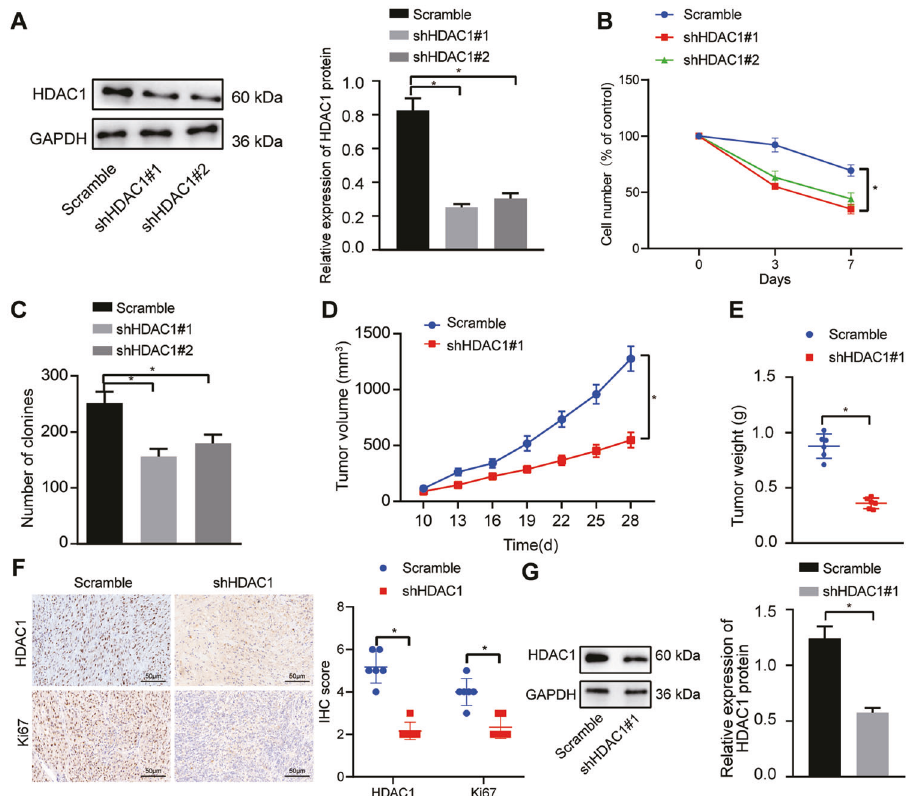
Fig. 2 Downregulation of HDAC1 represses the growth of CC cells in vivo and in vitro. A Knockdown ef fi ciency of shHDAC1#1 and shHDAC1#2 in TFK-1 cells detected by Western blot analysis. B Proliferation of TFK-1 cells upon HDAC1 silencing assessed by trypan blue staining. C The number of newly formed colonies in TFK-1 cells upon HDAC1 silencing tested by colony formation assay. D Tumor volume in nude mice in response to HDAC1 silencing. E Tumor weight in nude mice in response to HDAC1 silencing. F Immunohistochemical analysis of Ki67 and HDAC1 proteins in the tumor tissues of nude mice in response to HDAC1 silencing. G HDAC1 protein expression in tumor tissues of nude mice in response to HDAC1 silencing measured by Western blot analysis. * p < 0.05. In panels ( A ) and ( C ), data were compared by one- way ANOVA with Tukey ’ s post hoc test. In panels ( E – G ), data were compared by unpaired t -test. In panels ( B ) and ( D ), data were compared by repeated measures ANOVA with Bonferroni post hoc test. The cell experiment was independently repeated three times. n = 6 for animal